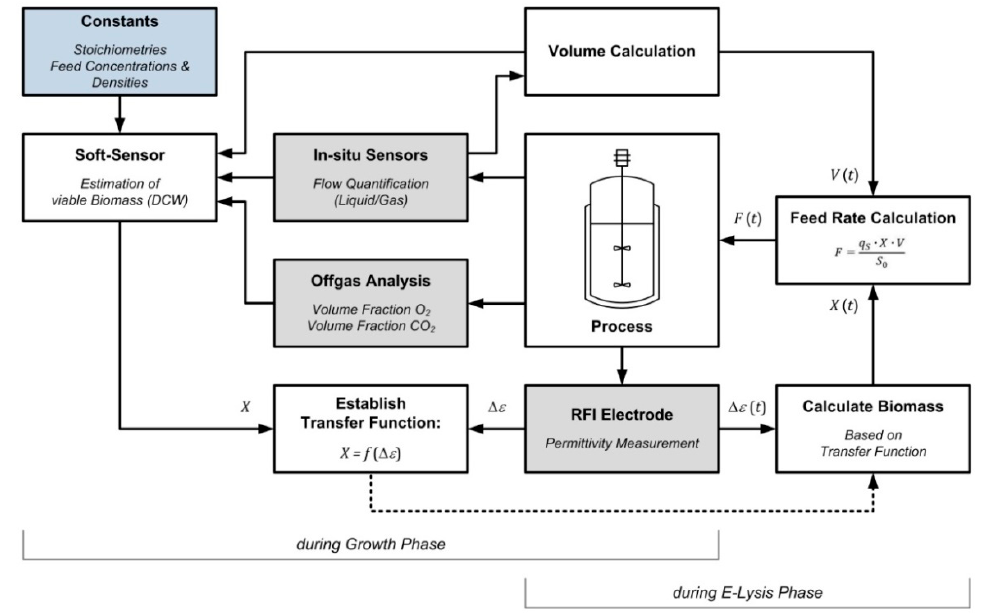
Figure 3. Schematic drawing of the feed control strategy during the E-lysis phase. Grey boxes indicate measurements, white boxes indicate calculation, blue boxes provide known constants.